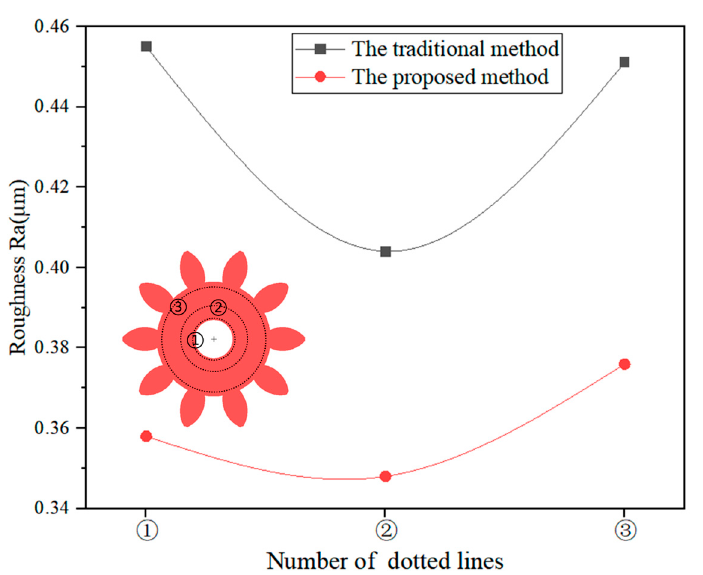
Figure 8. The roughness levels at different dotted lines on the gears fabricated by two methods.